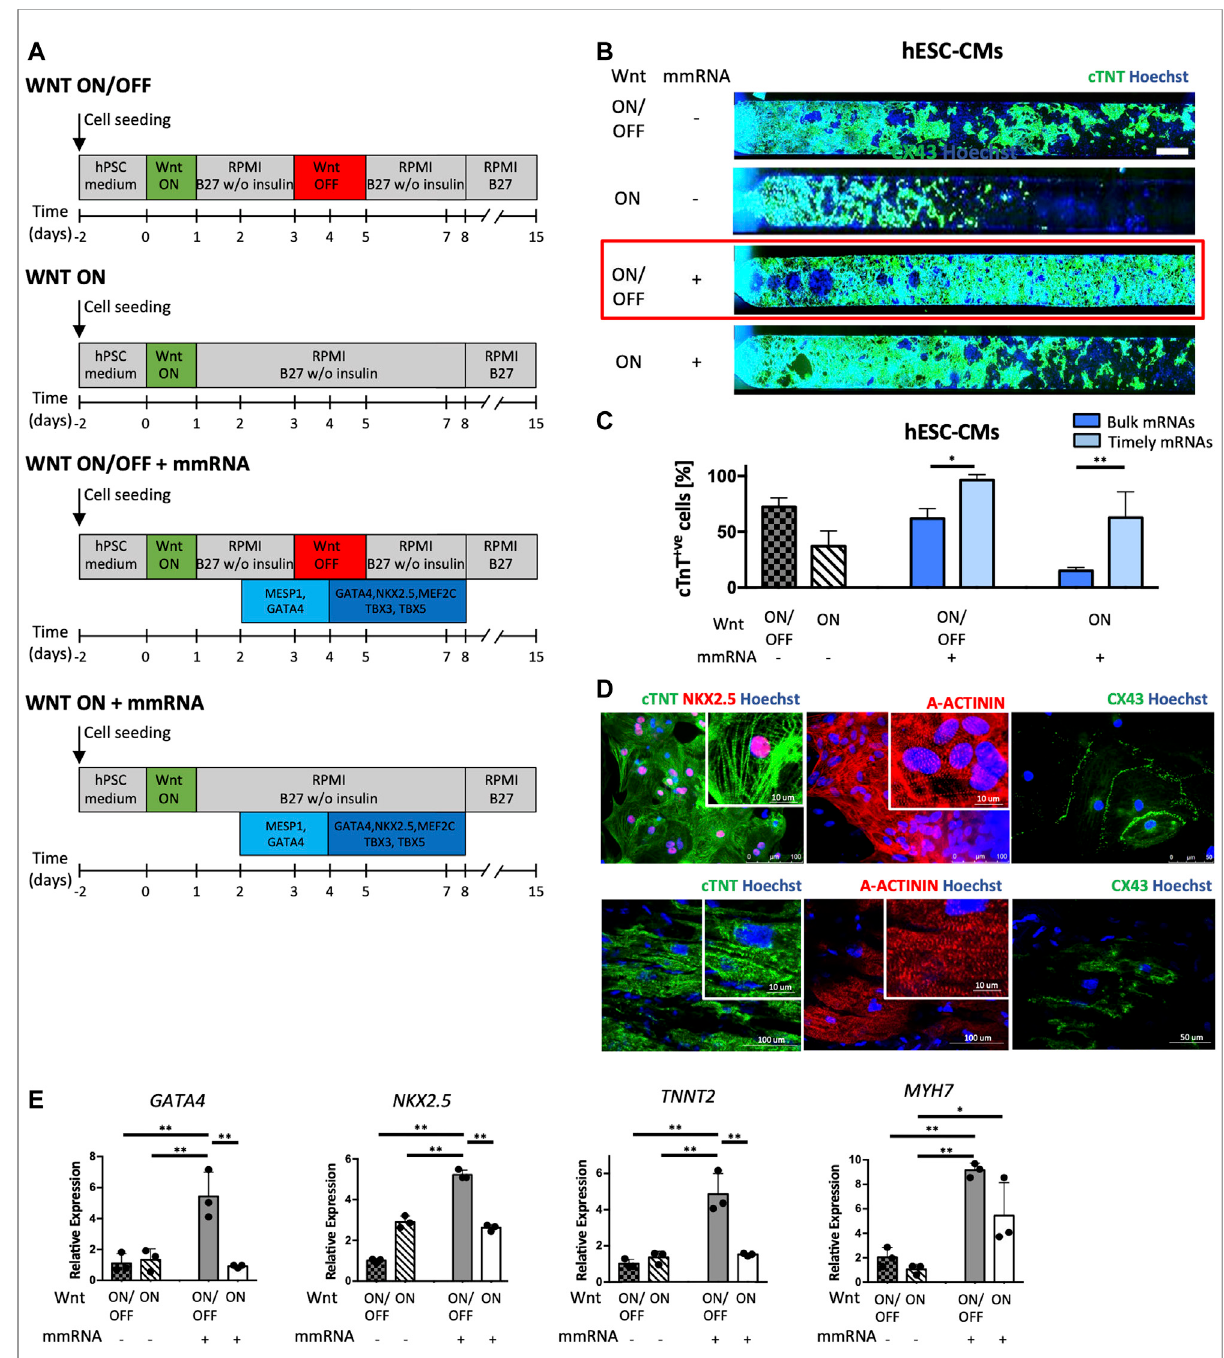
FIGURE 4 Cardiac differentiation on-chip by combining Wnt modulators and time patterned cardiac mmRNAs delivery. (A) Schematic representation of the four experimental strategies applied in parallel. The fi rst two strategies are controls, WNT ON/OFF (Lian X, 2012) and WNT ON respectively, without mmRNA transfections. The other two protocols implement WNT ON/OFF and WNT ON signaling in combination with cardiac mmRNA transfections applied in two phases: early phase (MESP1 and GATA4 for the fi rst 2 days) and late phase (GATA4, NKX2.5, MEF2C, TBX3, and TBX5 for thelast 4 days). (B) Immuno fl uorescence staining for cTNT (green)in CMs obtained from hESCs differentiatedinto micro fl uidic platform,in the four protocols implemented. Nuclei were counterstained with Hoechst. Scale bar 750 μ m. (C) Quanti fi cation of cTNT positive CMs from hESCs and iPSCs in the four protocols implemented. One-way ANOVA p -value < 0.05 (*); p -value < 0.01 (**). (D) Confocal images of Immunostaining of cardiac speci fi c proteins acquired; Top, cardiac troponin T (cTNT), NKX2.5, alpha-actinin (A-ACTININ) and connexin 43 (CX-43). Nuclei were counterstained with Hoechst. Bottom, immunostaining of cardiac troponin T (cTNT), alpha-actinin (A-ACTININ) and connexin 43 (CX-43) in human adult cardiomyocytes of the right atrium. (E) Gene expression normalized to GAPDH of GATA4, NKX2.5, TNNT2, and MYH7, in